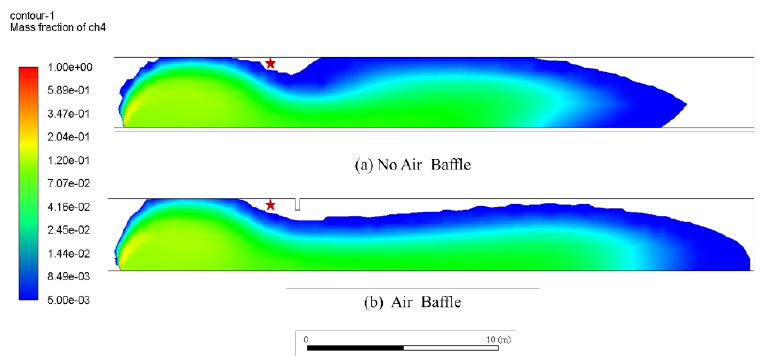
Figure 9. Under normal ventilation conditions, the dangerous area of the gas cabin with ( a ) No Air Baffle and ( b ) Air Baffle, when the gas leakage continues for 10 s.